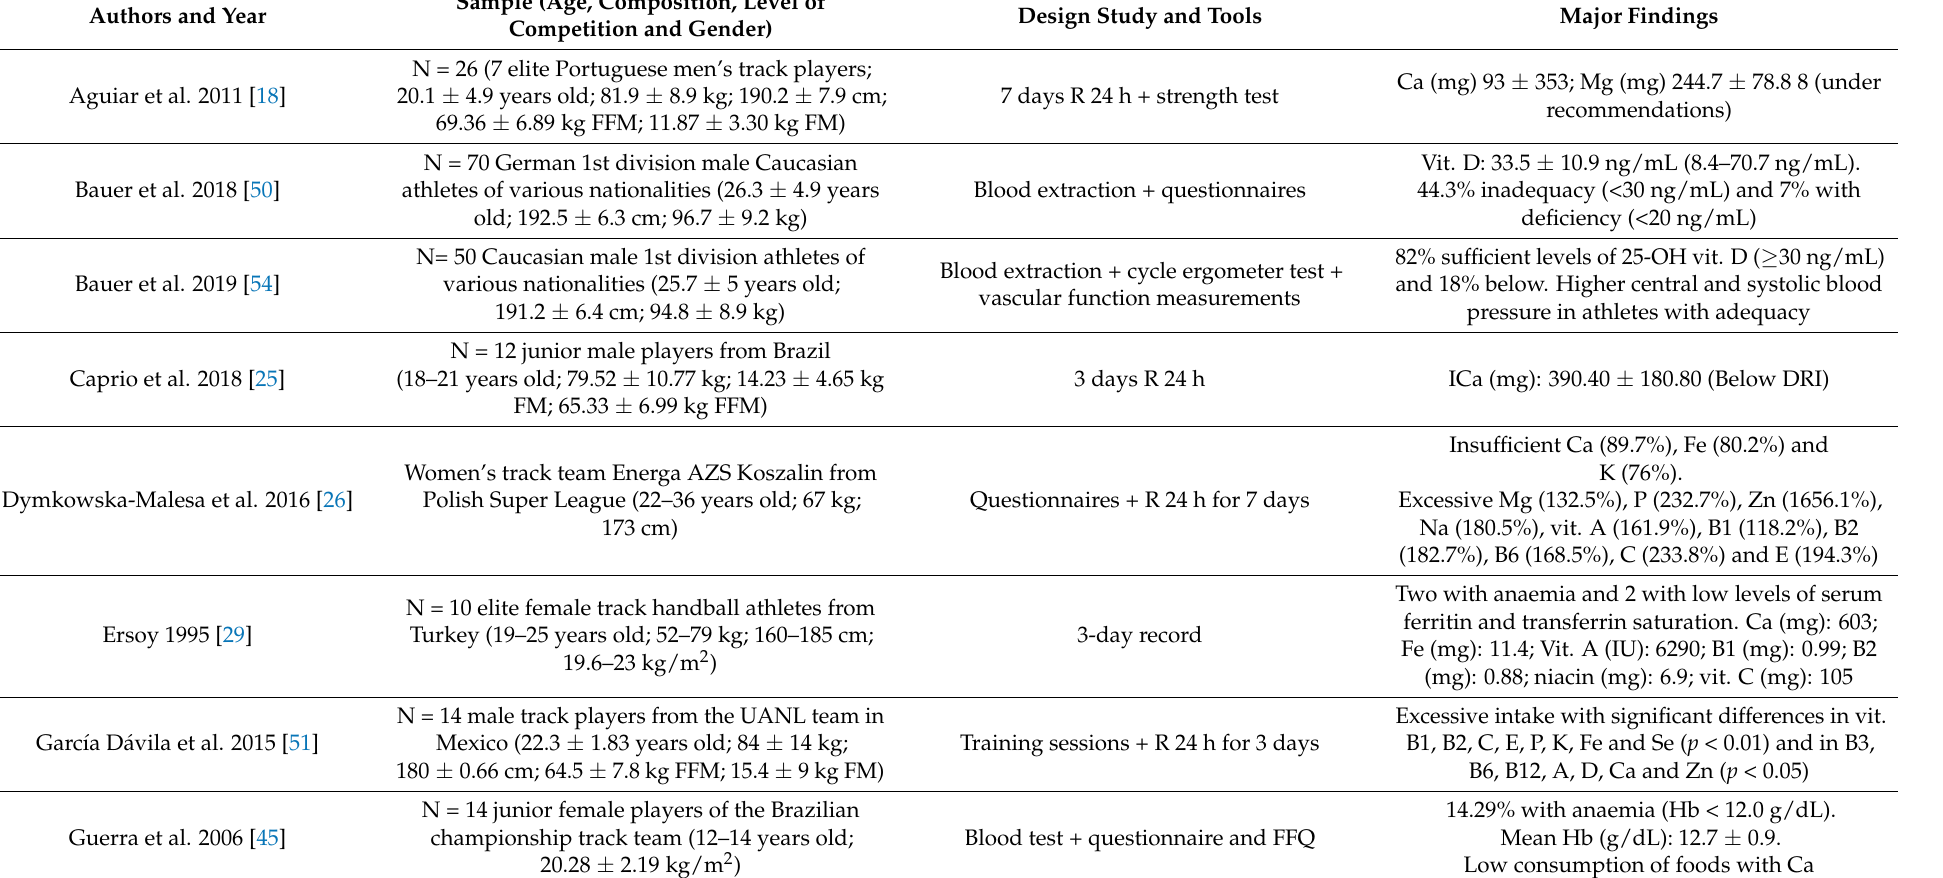
Table 3. Status and intake of micronutrients (vitamins and minerals) and associated biochemical